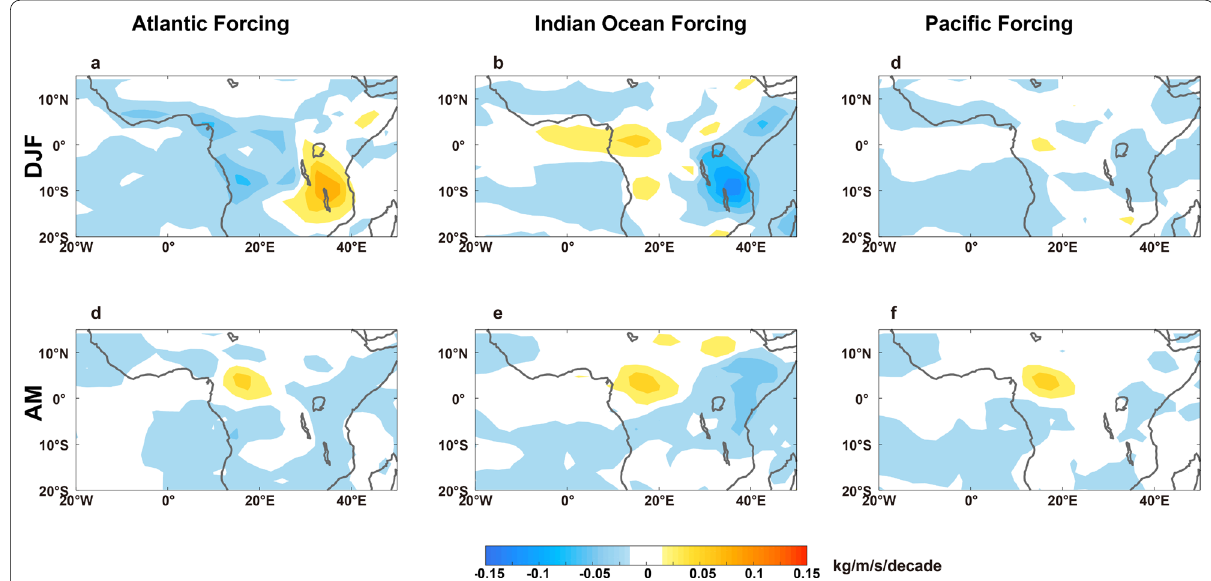
Fig. 9 Simulated seasonal change of vertically integrated moisture flux convergence in atmospheric models. Color mapping in a – c illustrates the convergence change (increase, blue color; decreased, yellow color) forced by the tropical Atlantic, Indian Ocean and Pacific during the boreal winter dry season (DJF). d – f same as a – c but for the boreal spring wet season (AM). The changes of convergence agree with specific humidity (Fig.